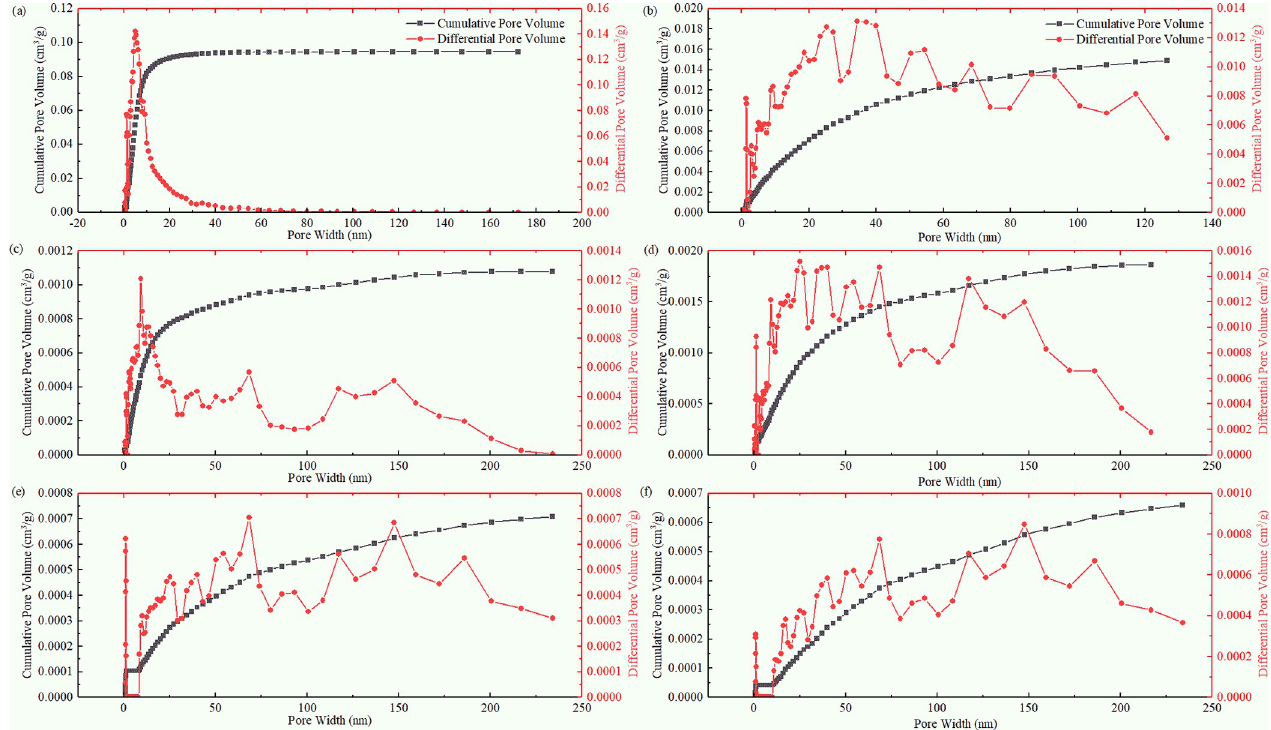
Fig 5. Cumulative pore volume and differential pore volume diagram of coals. (a) PH Sample, (b) JB Sample, (c) LH Sample, (d) HG Sample, (e) CV Sample, (f) YW Sample.